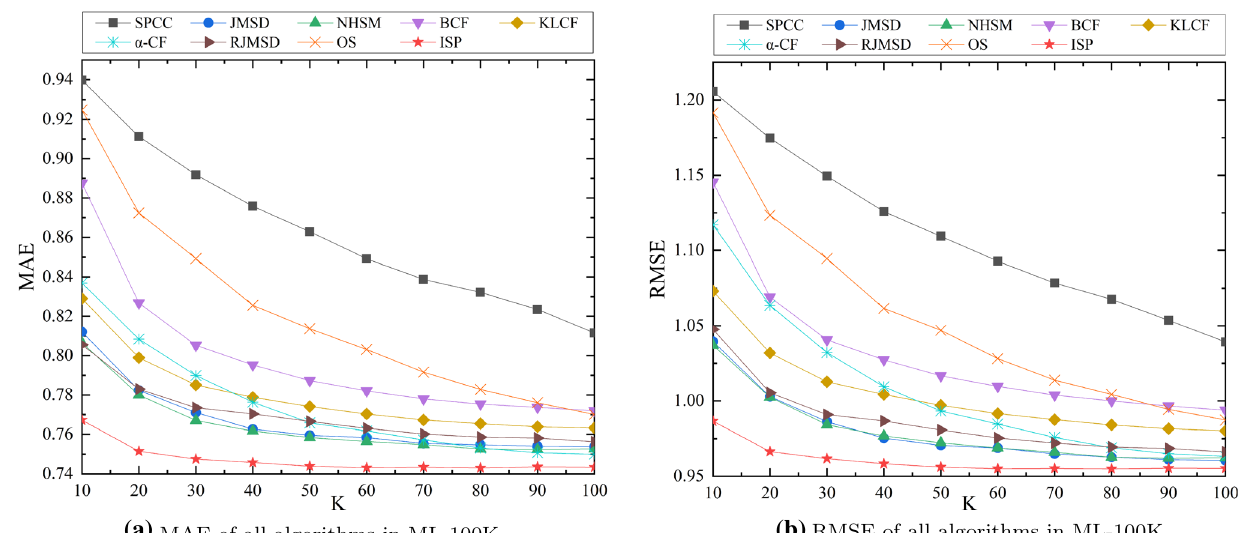
(a) MAE of all algorithms in ML-100K. (b) RMSE of all algorithms in ML-100K. Fig. 3 MAE and RMSE values of all algorithms in ML-100K